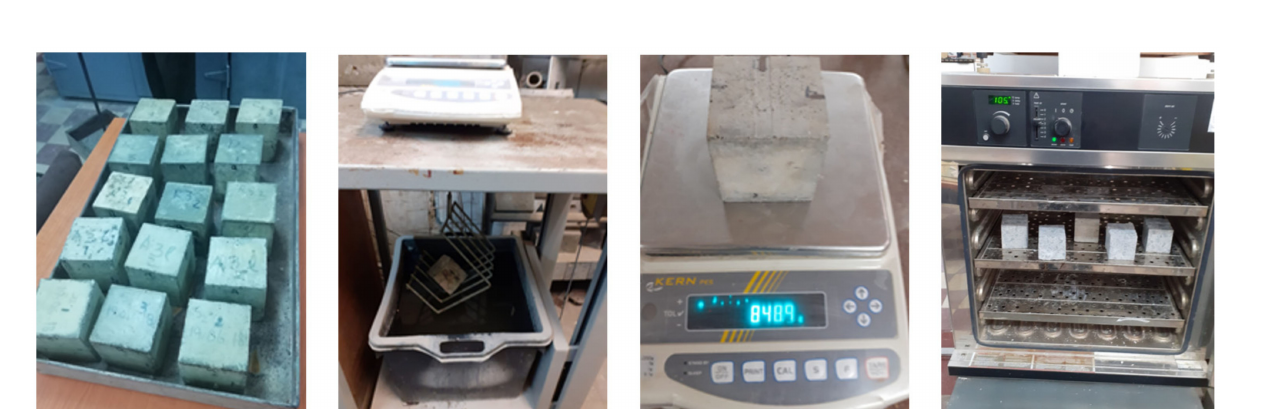
Figure 3. Hydrostatic weighing of cubes with 71 mm